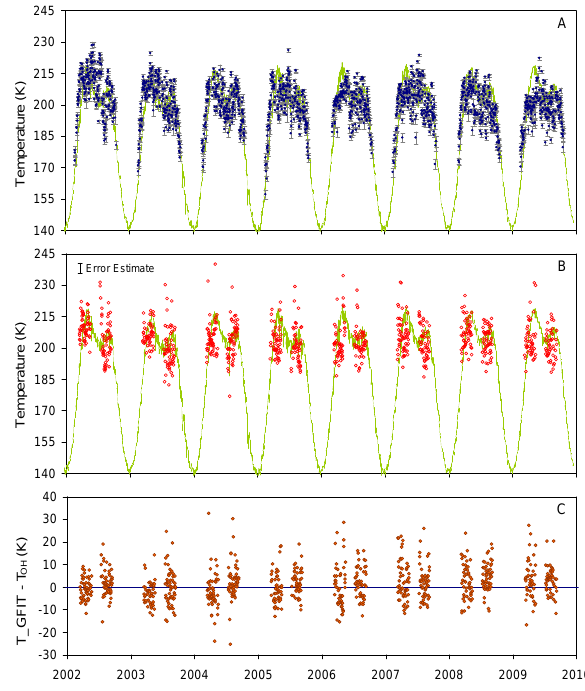
Figure 1. Davis hydroxyl (1677 nights : panel A) and the SABER T_GFIT evaluation (847 2 Fig. 1. (A) Davis hydroxyl nightly average temperatures (1677 nights : panel B) nightly averages overplotted on MSISE-90 model temperatures for 69°S). 3 nights) overplotted on MSISE-90 model temperatures for 69 ◦ S. Er- Error bars for the Davis OH series are 1 standard error-in-the-mean. An estimate of the 4 ror bars for the Davis OH series are 1 standard error-in-the-mean. SABER error (5K) is plotted for comparison. Panel C shows the SABER–DavisOH 5 (B) SABER T GFIT nightly averages (847 nights) with an esti- difference.6 mate of the SABER error (5K) plotted for comparison with the OH temperatures. (C) The SABER-DavisOH difference for coincident